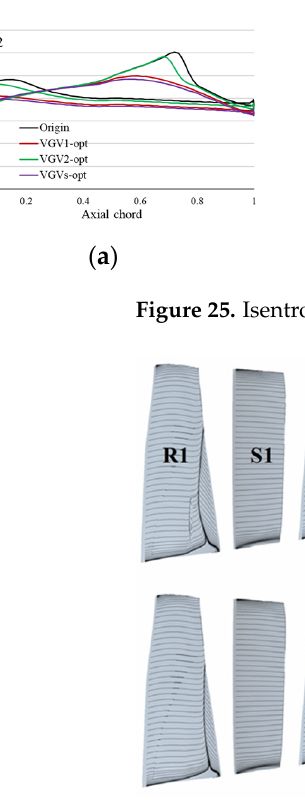
Figure 26. Limited streamlines on blade surfaces of first three stages (VGVs adjustment).